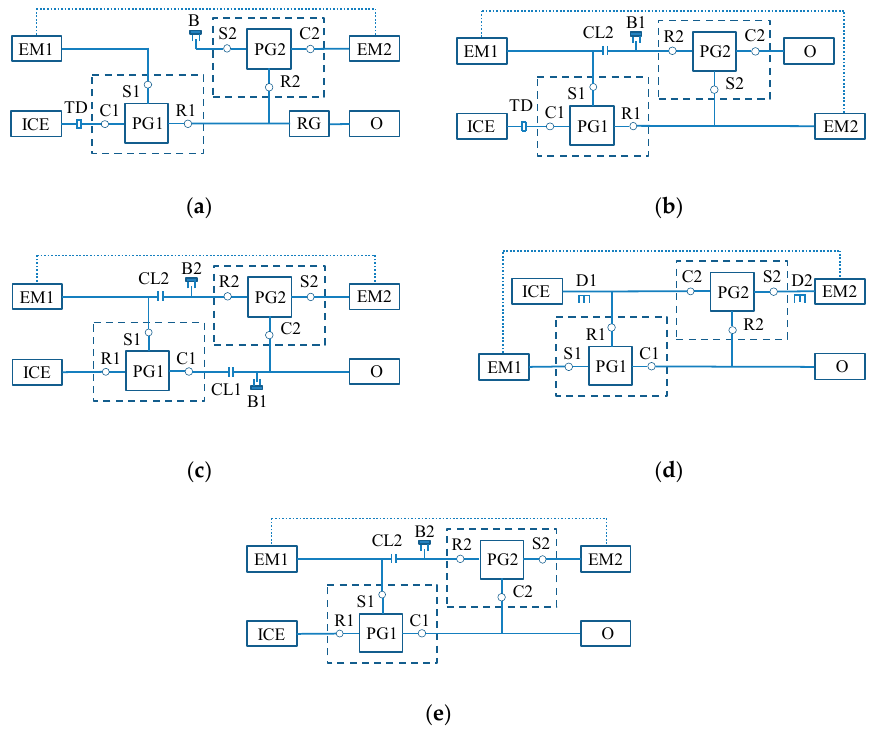
Figure 20. Type-c architecture: ( a ) THS with dual-PG; ( b ) General Motors (GM) advanced hybrid system (AHS); ( c ) Timken EVT; ( d ) Renault IVT; ( e ) Voltec II. (TD—torsional damper; D—dog clutch).